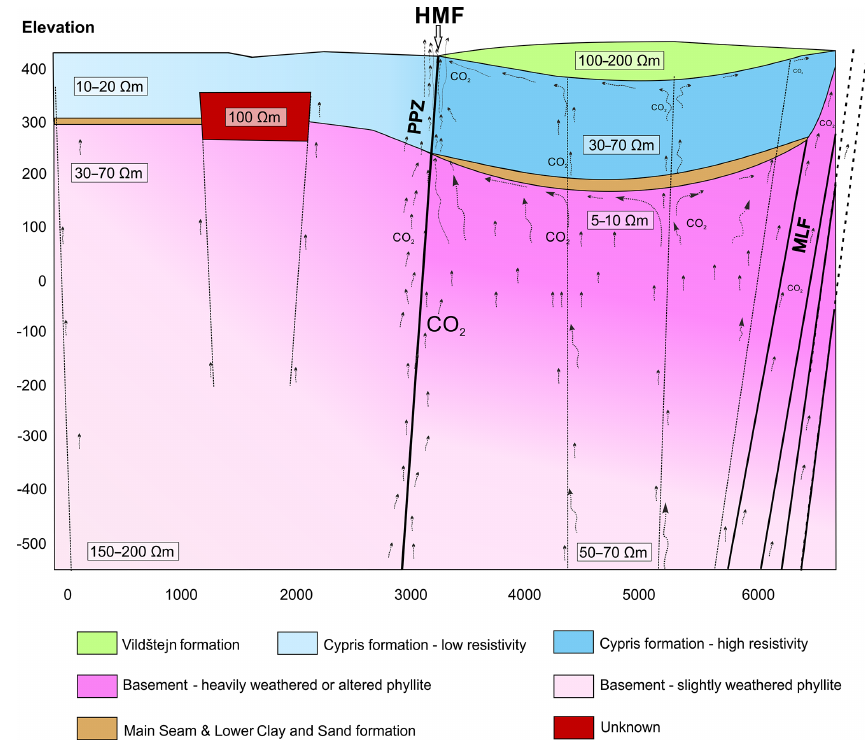
Figure 8. Conceptual W–E model of the topmost 1000m of the survey area. Stratigraphic units are based on drill core information from Fig. 2 for the first 100–300m. While the Cypris and Vildštejn formations are characterized by higher resistivities in the eastern part, the basement features lower resistivities, which is attributed to CO 2 ascent, rock alteration, and highly mineralized water. Dashed lines are inferred faults. The first few meters of Quaternary coverage are not